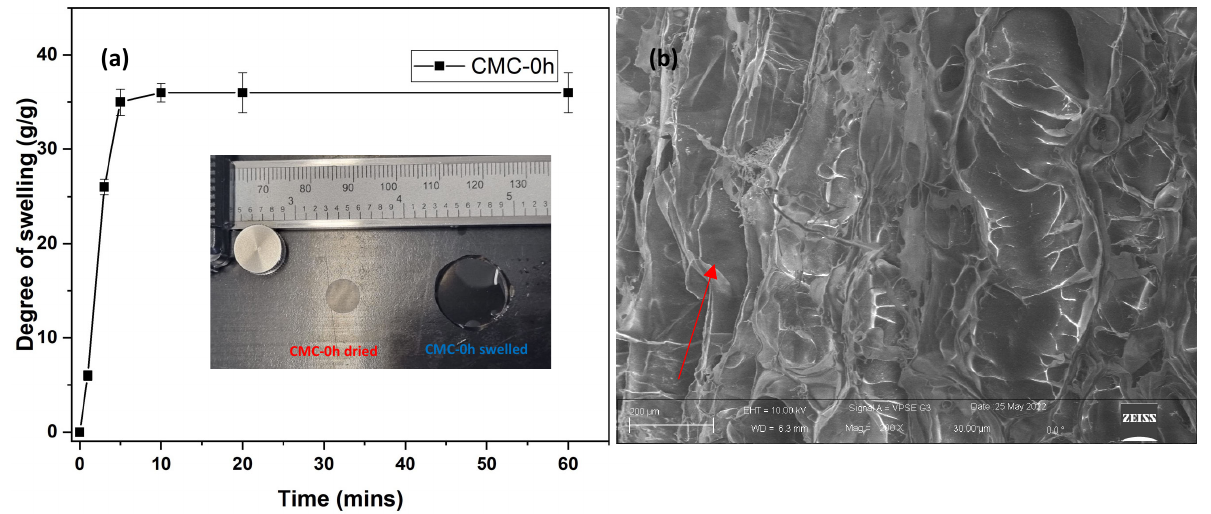
Figure 4. ( a ) Plot representing degree of swelling of CMC ‐ 0 h film at different time intervals (inset: image of CMC ‐ 0 h film in dry and swelled state) and ( b ) SEM image of freeze ‐ dried CMC ‐ 0 h hydrogel (Pores are indicated by red arrows).